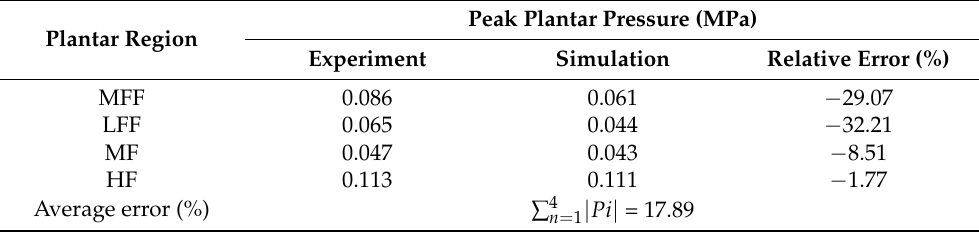
Figure 3. The subdivided regions and comparison between predicted pressure distribution and experimental pressure data: ( A ) plantar region and ( B ) sole region; both the plantar and sole areas were further divided into four specific regions, including medial forefoot (MFF), lateral forefoot (LFF), midfoot (MF), and hindfoot (HF) for foot model, medial fore-sole (MFS), lateral fore-sole (LFS), medial hind-sole (MHS), and lateral hind-sole (LHS) for shoe model. Table 2. Comparison of predicted peak plantar pressures and experimental pressure insole data in 4 plantar regions during balanced standing.